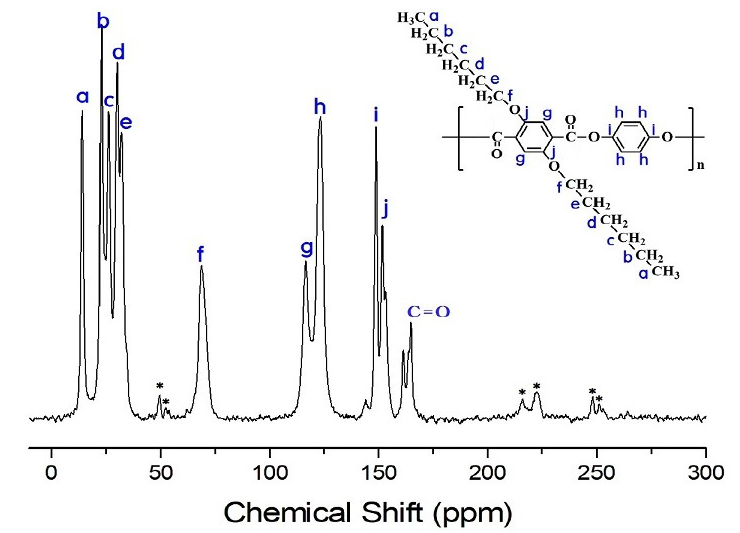
Figure 9. Solid state 13 C CP / MAS NMR spectrum of HQ-6 at room temperature. The spinning sidebands are marked with asterisks.